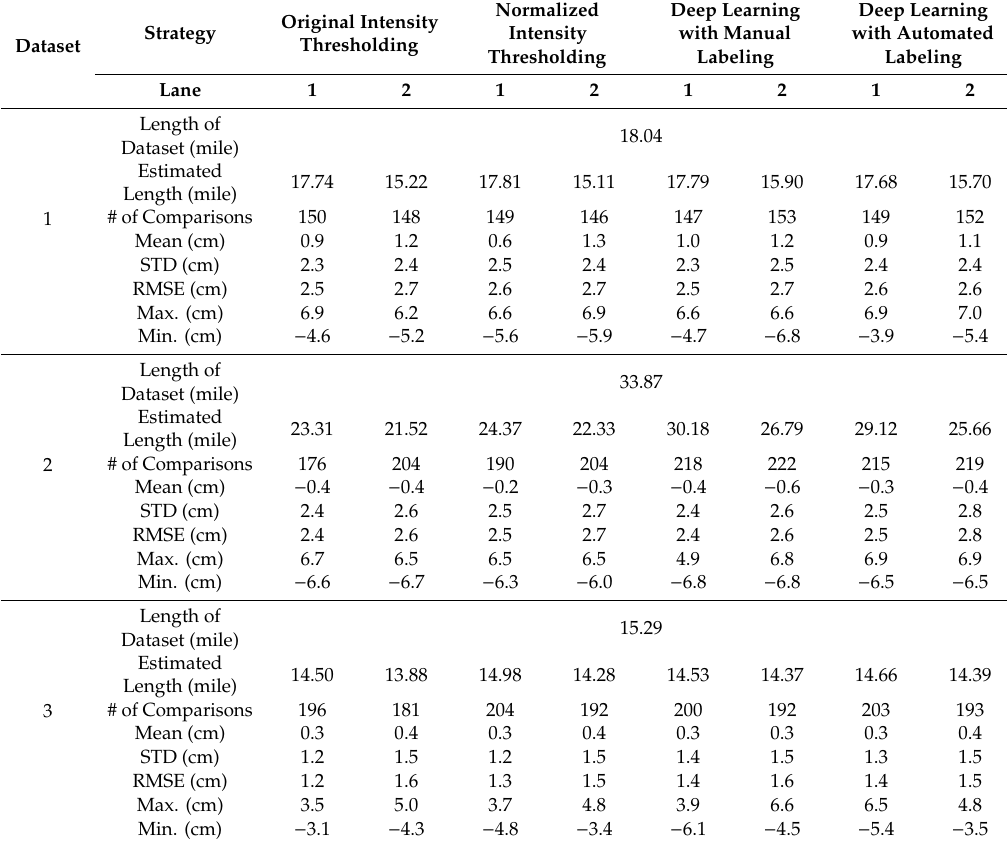
Table 11. Lane width di ff erence statistics between various strategies and manual measurements.